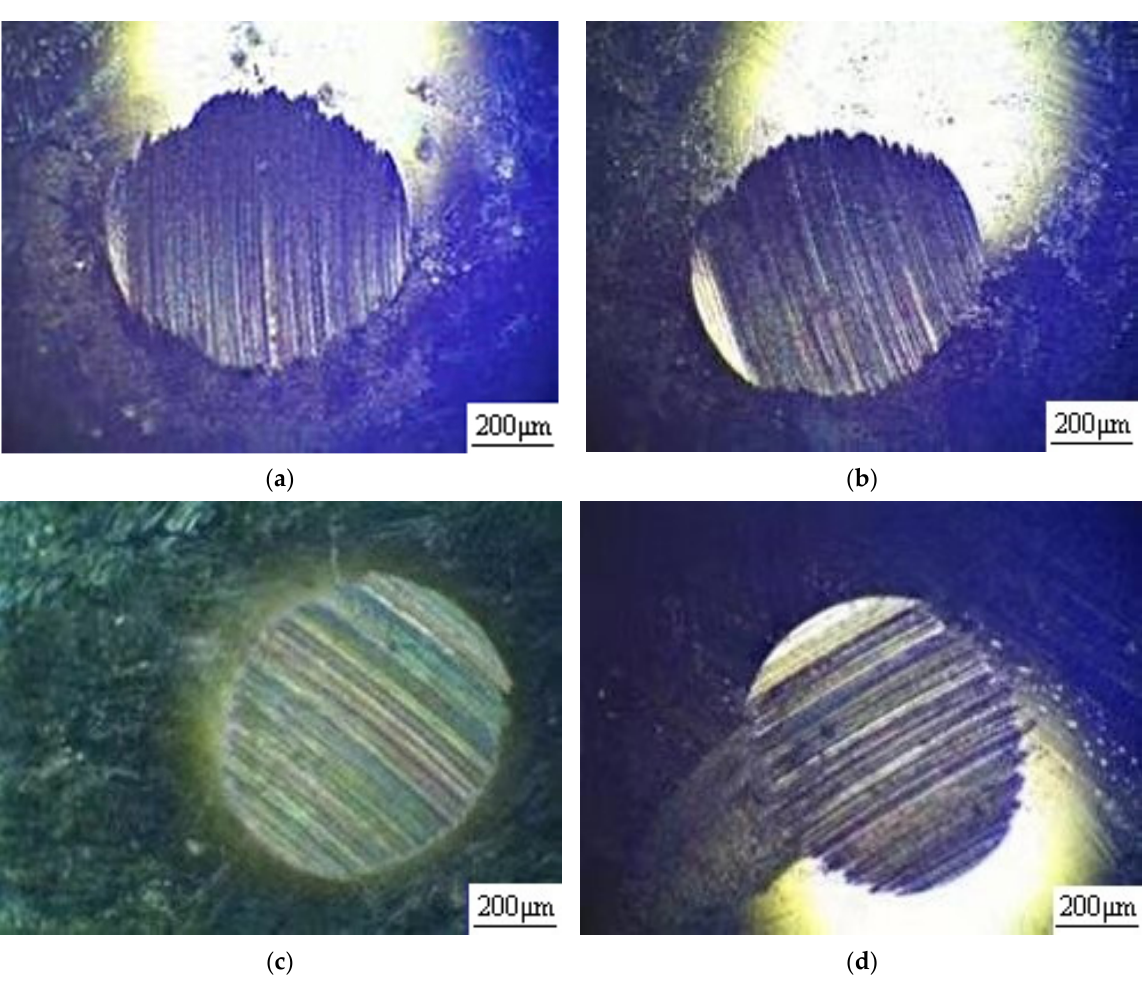
Figure 5. Grease wear marks at room temperature: ( a ) PTFE; ( b ) Graphene; ( c ) CNTs; ( d ) WS 2 .